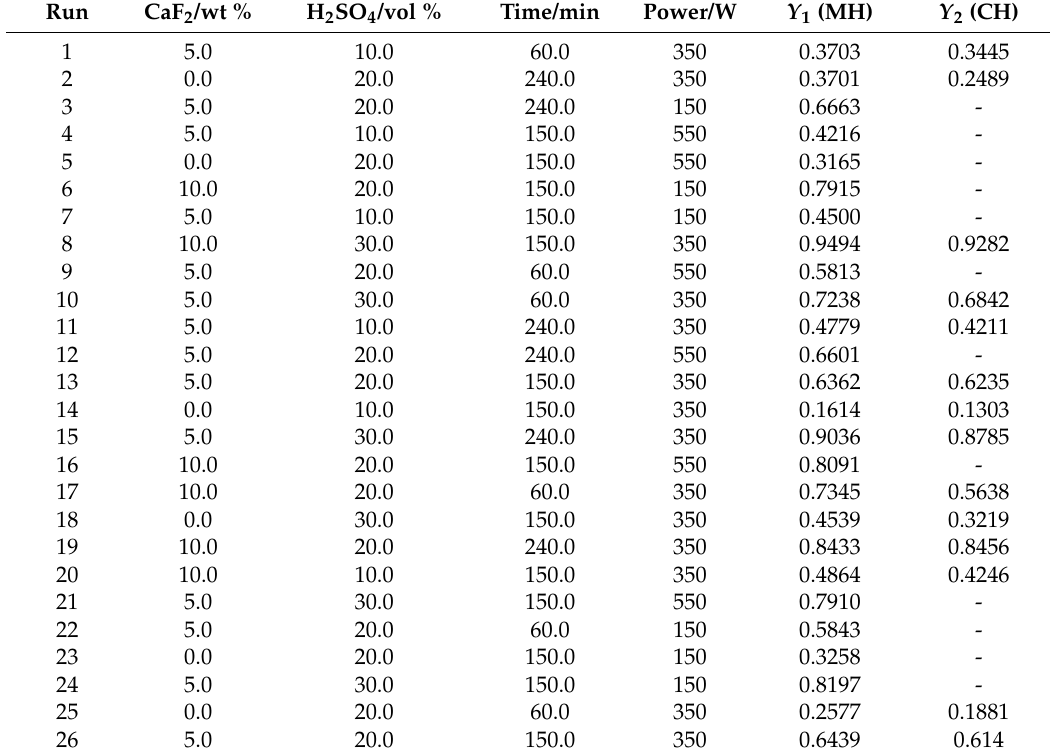
Table 4. Experimental design matrix and results.